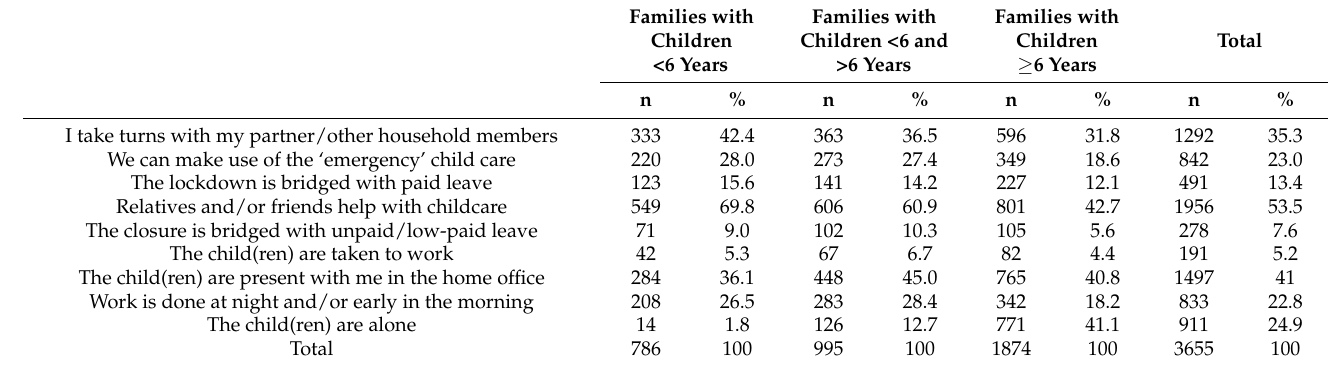
Table 3. Most popular coping strategies according to the children’s age.